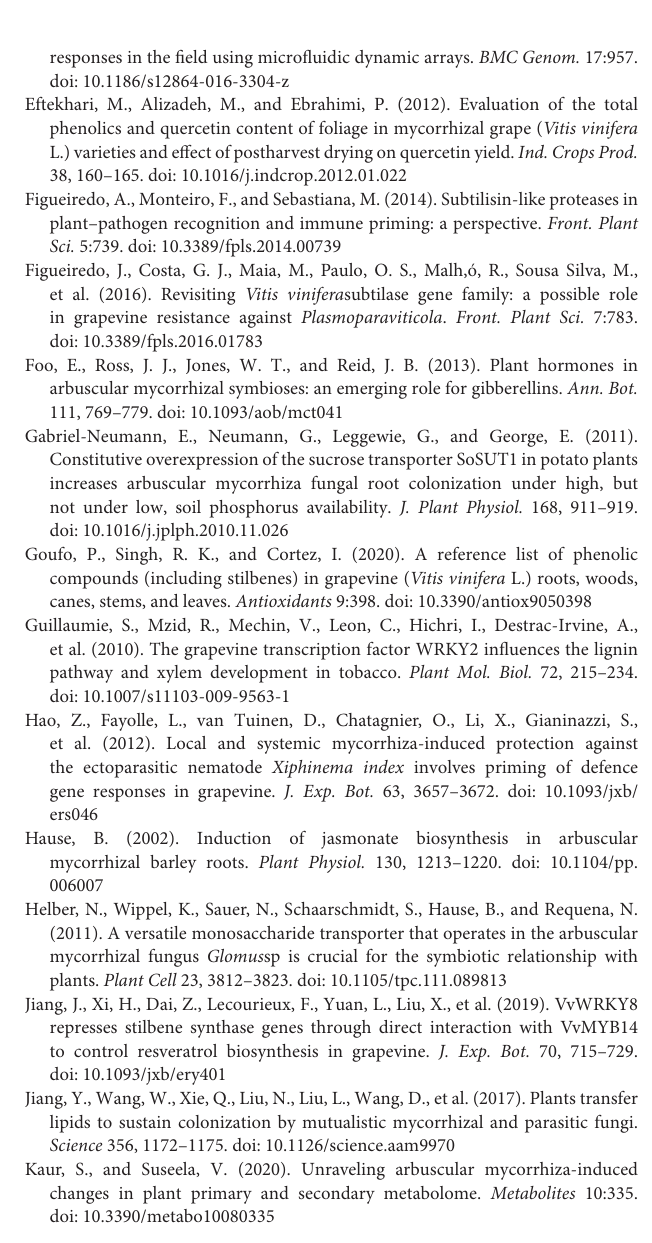
Supplementary Tables 7 and 8 | Melt curves of qPCR amplicons in roots and